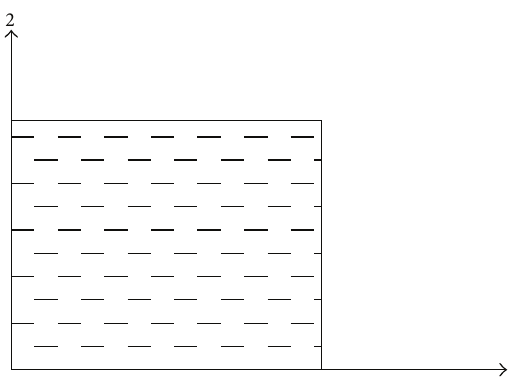
Figure 7: Unidirectional discontinuous fiber